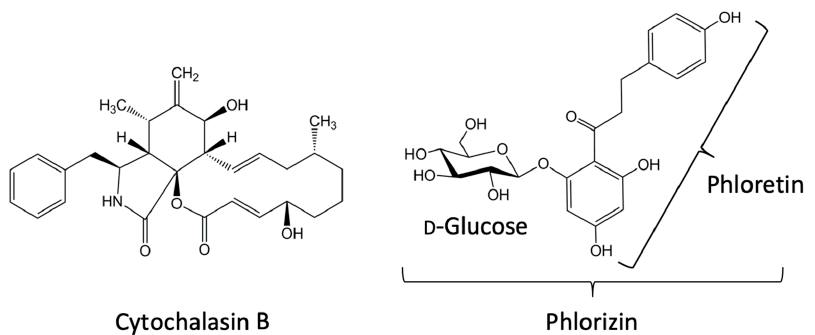
Figure 1. Structures of cytochalasin B, phlorizin, and phloretin.